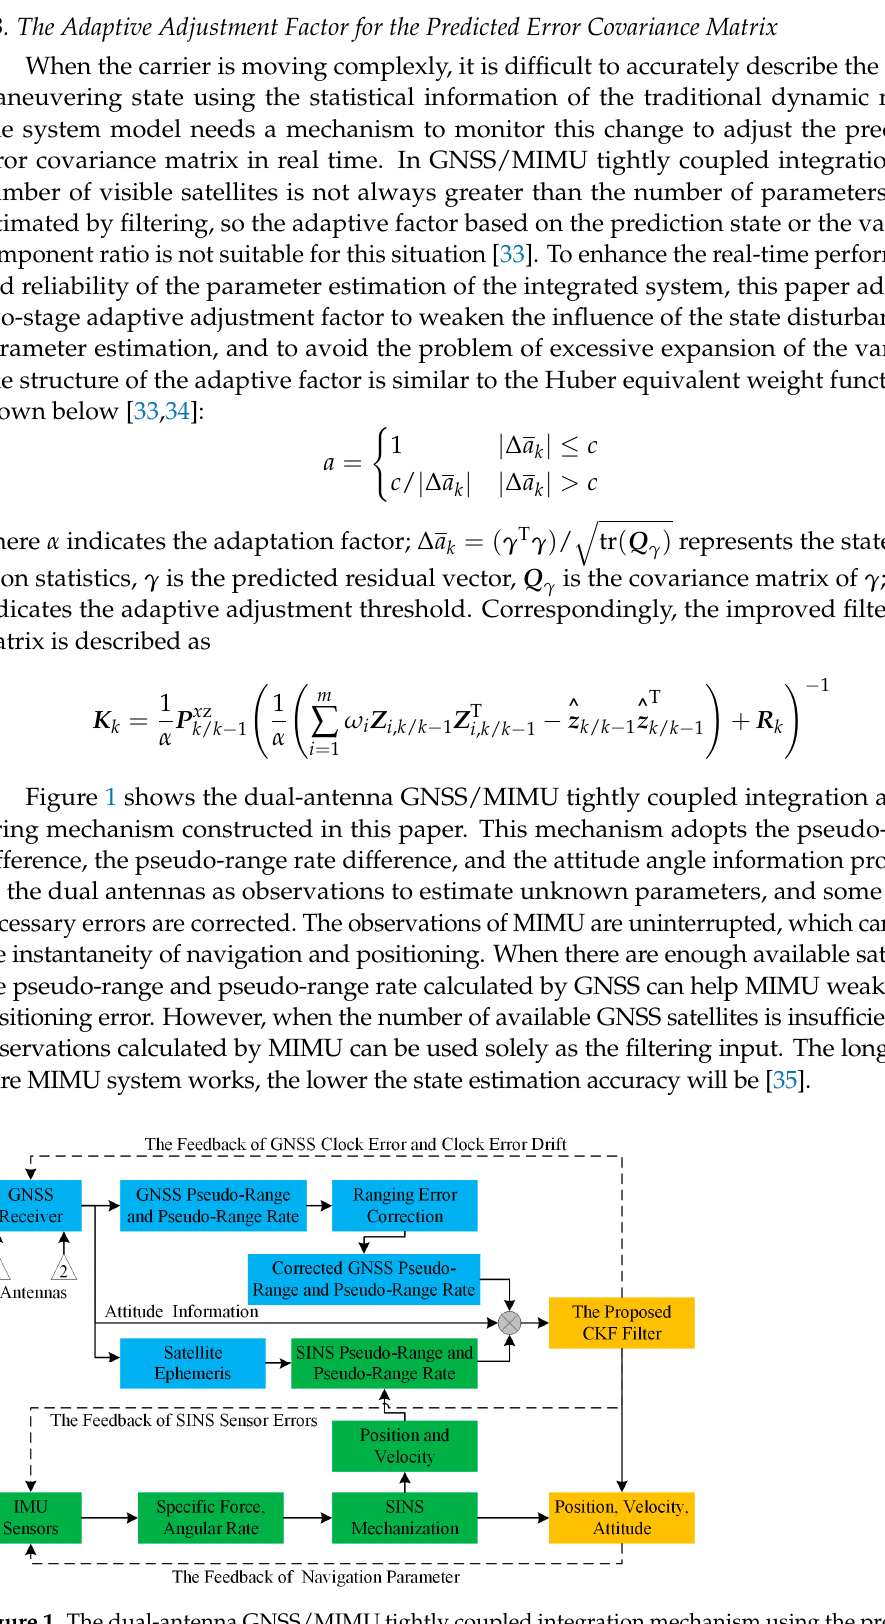
Figure 1. The dual-antenna GNSS/MIMU tightly coupled integration mechanism using the proposed CKF filter. GNSS: Global Navigation Satellite System; IMU: inertial measurement unit; MIMU: micro- electro-mechanical system–grade IMU; SINS: Strapdown Inertial Navigation System; and CKF: cubature Kalman filter.